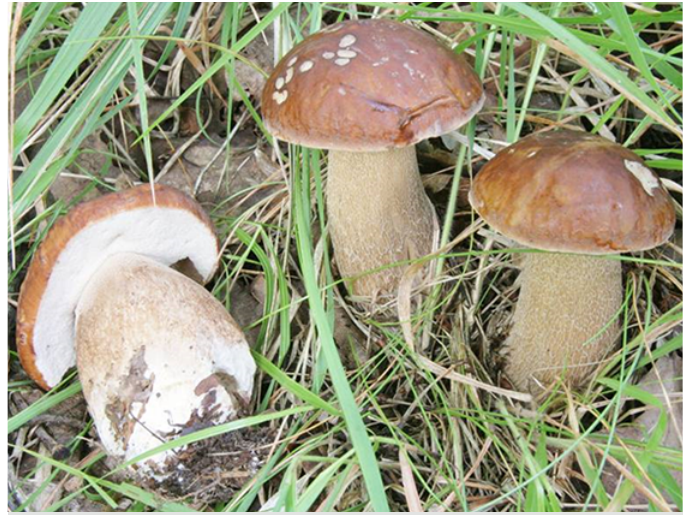
Fig. 2 Picture of B. reticulatus